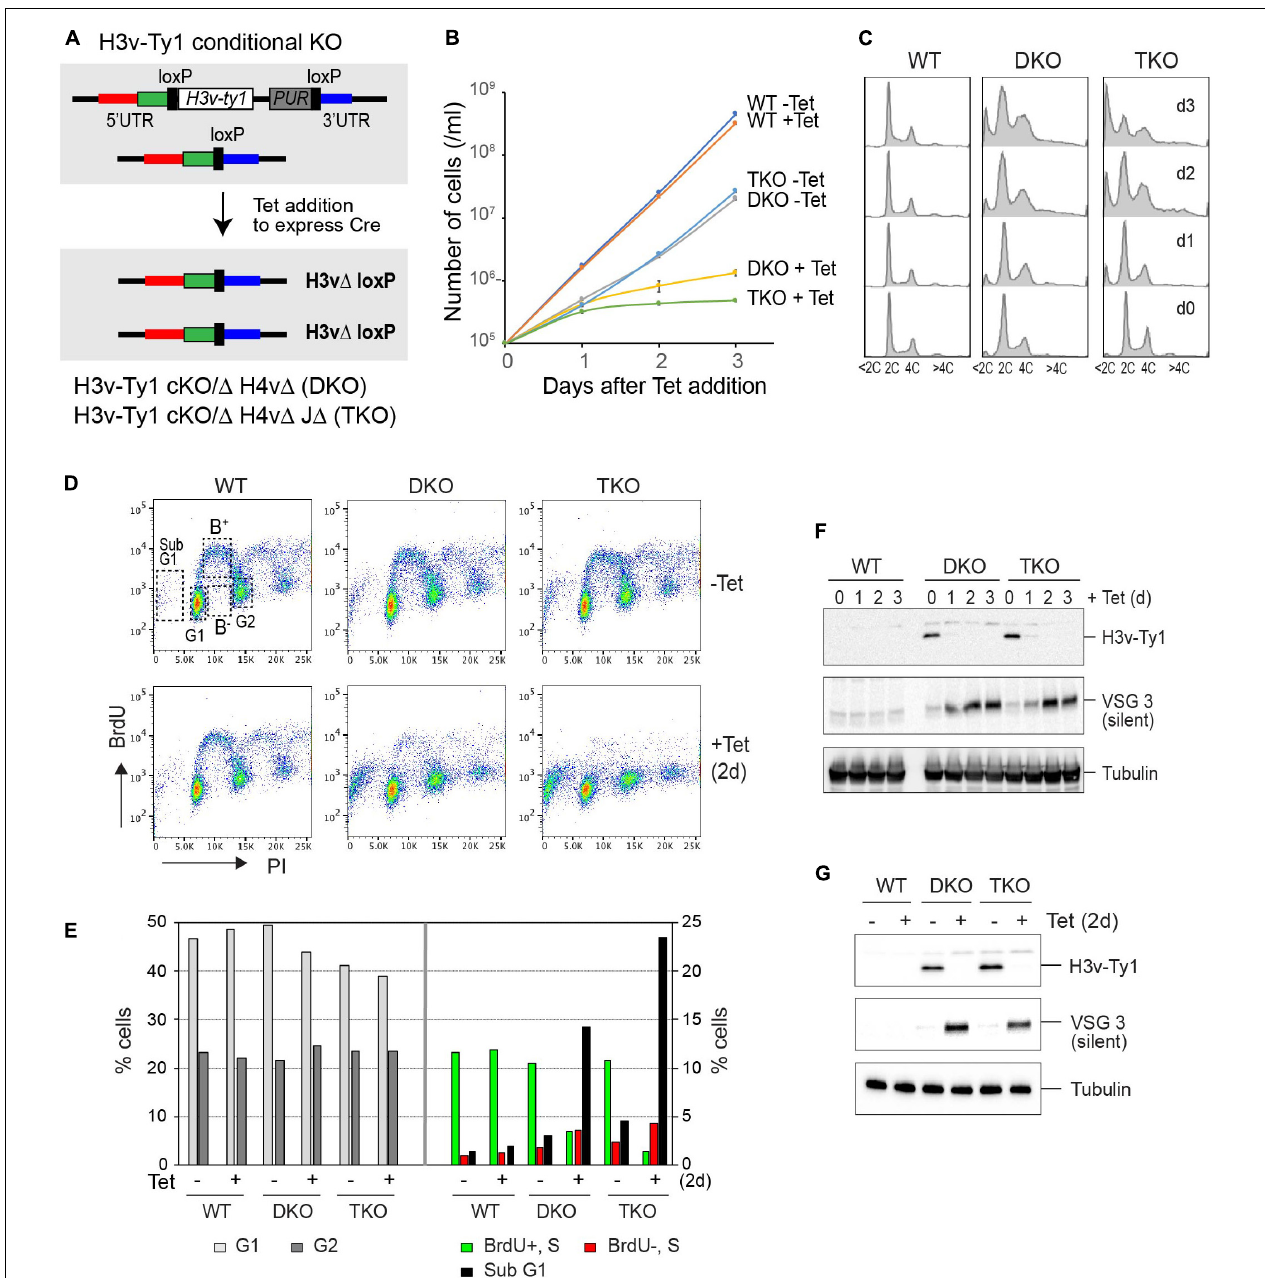
FIGURE 1 | Genetic interaction between H3v, H4v, and base J in proliferation, cell-cycle progression, and DNA replication. (A) Strategy to generate a conditional double KO (DKO, floxed H3v-Ty1 in H4v (cid:49) strain) and a conditional triple KO (TKO, floxed H3v-Ty1 in H4v (cid:49) J (cid:49) strain). The strain has one H3v allele deleted and the other H3v allele replaced with a floxed H3v-Ty1 and PUR marker. Cre protein expressed by tetracycline removes the floxed H3v-Ty1-PUR in the DKO or TKO, generating H3v (cid:49) H4v (cid:49) (DKO + Tet) or H3v (cid:49) H4v (cid:49) J (cid:49) (TKO + Tet) cells. (B) Cell growth in DKO and TKO mutants upon Tet induction. WT, DKO, and TKO strains were treated with tetracycline, and cell count was monitored daily for 3 days in triplicate. (C) Cell-cycle progression in DKO and TKO mutants upon Tet induction. Cells from (B) were fixed, stained with propidium iodide (PI), and analyzed by flow cytometry. (D) Bromo-2 (cid:48) deoxyuridine (BrdU) incorporation in DKO and TKO mutants upon Tet induction. WT, DKO, and TKO strains untreated or treated with tetracycline for 2 days were pulse-labeled with 500 µ M BrdU for 40 min and fixed. Cells were stained with PI (staining bulk DNA) and anti-BrdU-Alexa 488 (staining newly replicated DNA) and then analyzed by flow cytometry. (E) Quantification of BrdU-positive or -negative S phase cells and cells in G1, G2, or sub-G1 stage. (F) Western blot control for experiment B. Depletion of H3v-Ty1 protein and derepression of silent VSG3 protein in DKO and TKO mutants upon Tet induction. Denatured whole cells from (B) were analyzed by western blot. Tubulin served as a loading control. (G) Western blot control for experiment